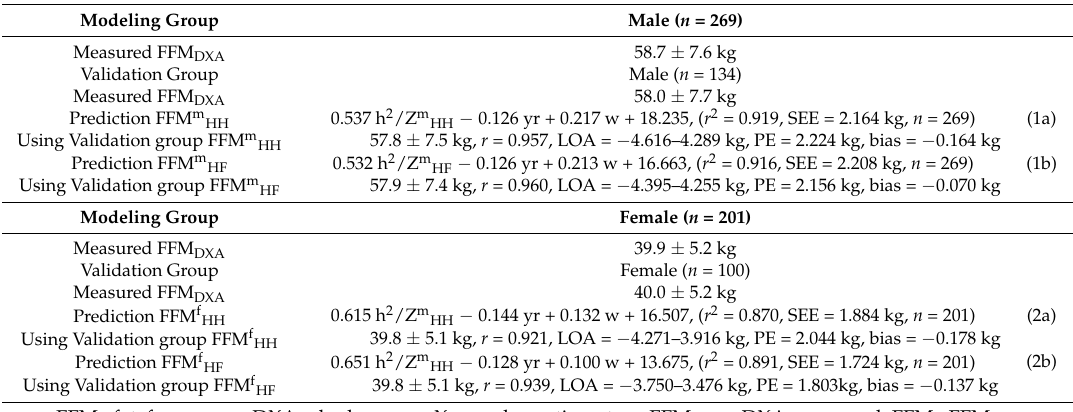
Table 3. Prediction equation for the validation group.